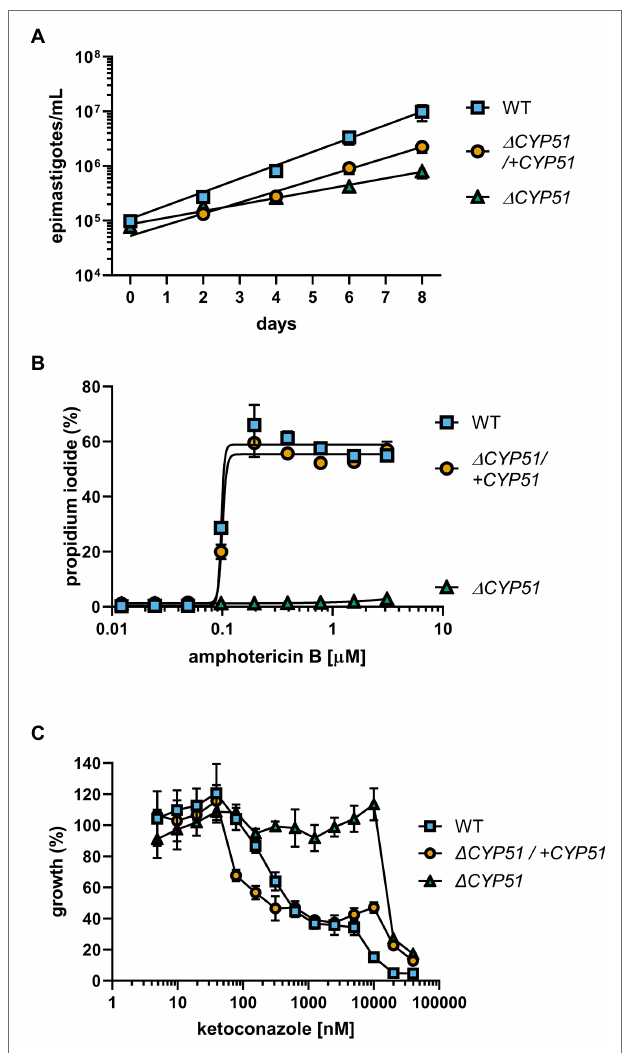
FIGURE 3 | (A) Enumeration of epimastigote concentration every 48 h starting at 1e5 epimastigotes/ml (n = 3), mean ± SD shown. WT epimastigotes exited the logarithmic phase of growth after day 8. (B) Measurement of epimastigote membrane integrity by flow cytometry using propidium iodide staining following incubation for 4 h with the indicated concentrations of amphotericin B (n = 3), mean ± SD shown. (C) Growth of epimastigotes (8 days) relative to samples without ketoconazole treatment, starting at 1e5 epimastigotes/ml (n = 3), mean ± SD